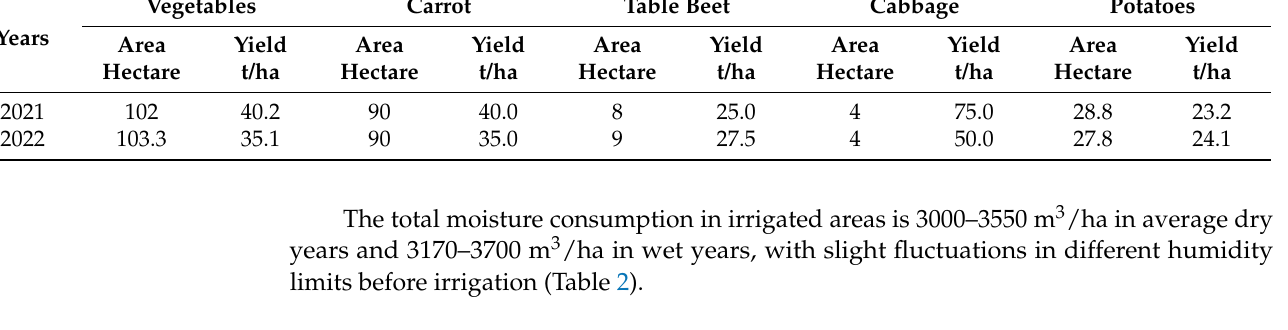
Table 2. Elements of water balance, evaporation and productivity of spring wheat in the farm “Sergey” of the Aksu irrigation basin.